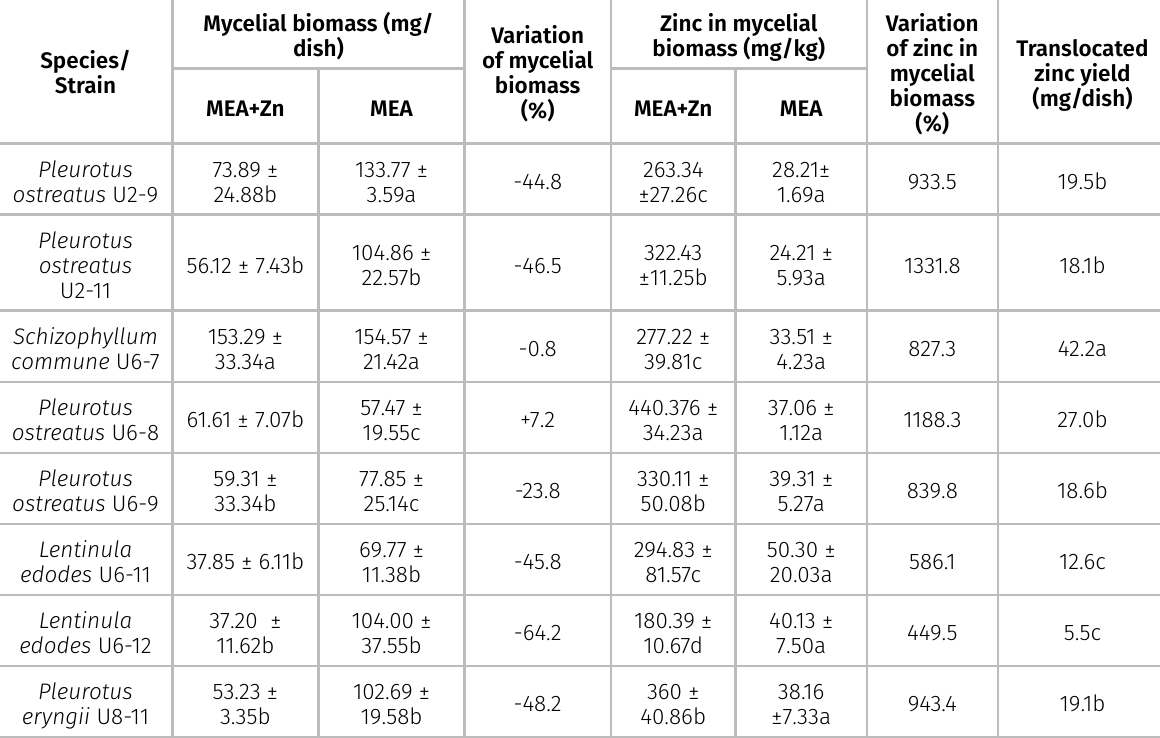
Table II. Translocated zinc per Petri dish yield, zinc bioaccumulated in mycelial biomass, and mycelial biomass (dry basis) grown in malt extract agar with and without addition of 7.5 mg/L